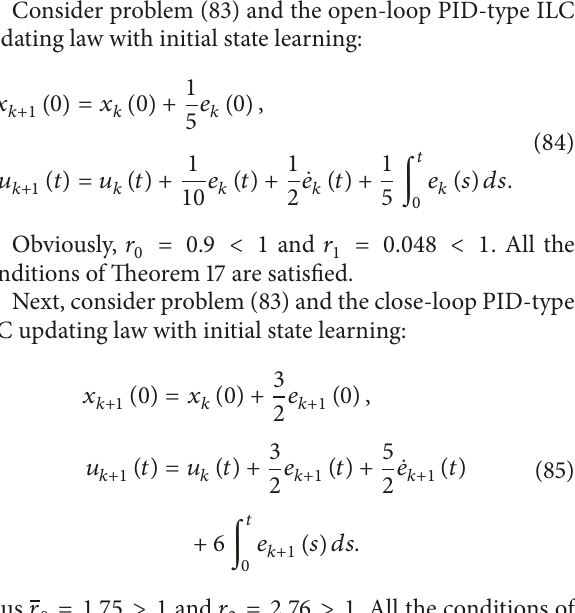
and the desired reference trajectory 𝑦 𝑑 (𝑡) = 10 sin (10𝜋𝑡)(1 + cos (10𝜋𝑡)) + 2, 𝑡 ∈ [0,